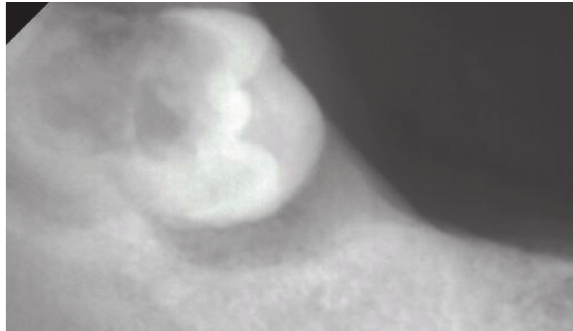
Figure 3: A bone transmission image was seen around the tooth